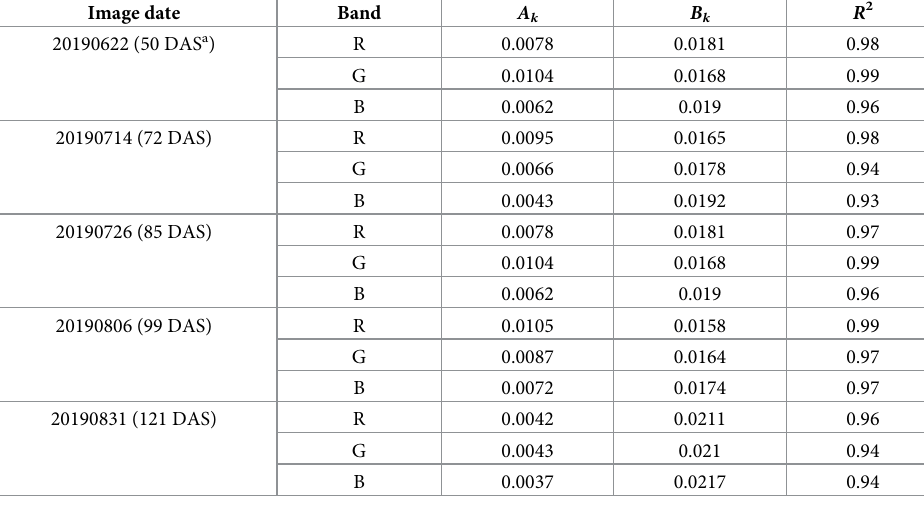
Table 3. Results of the exponential regression model on each flight